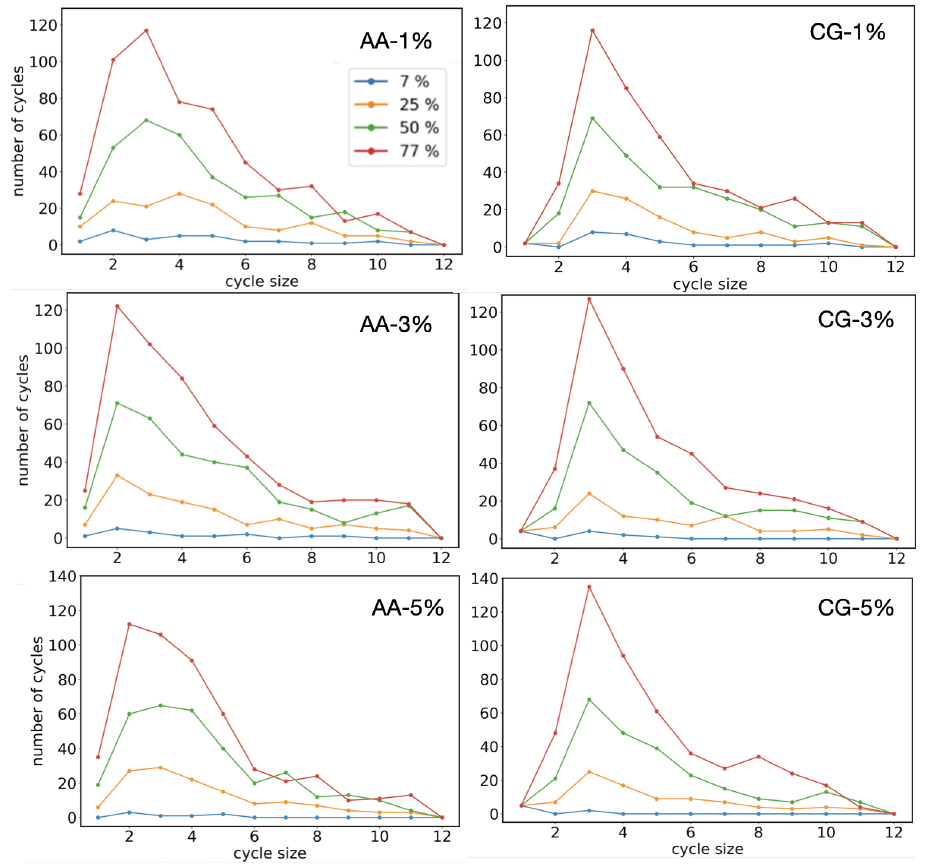
Figure 9. Cycles size distribution for the AA (from Ref. [10]) and CG systems at different stages of the polymerization process in double bonds conversion values and different initial radical concen- trations. The distribution was computed as the mean over a set of 20 independent trajectories. The standard deviation (not reported in figure) was found to be always less than 5% of the corresponding mean